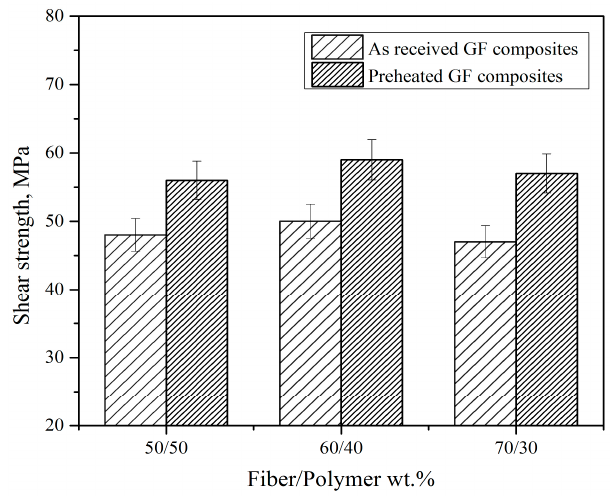
Figure 6. Shear strength of composites reinforced with as-received GF (route 3) and preheated at 350 °C GF (route 4).